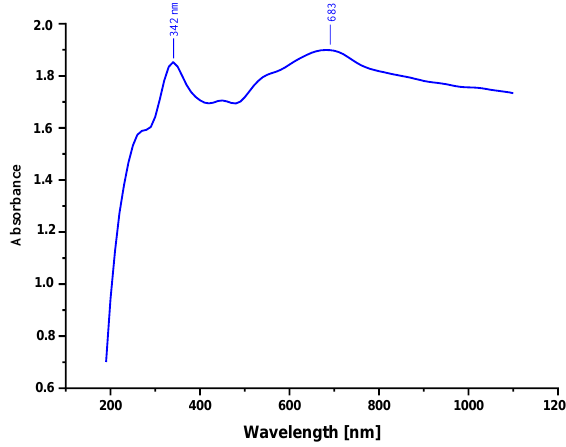
Figure 4. UV-vis spectra of PANI@Fe 2 O 3 composites.